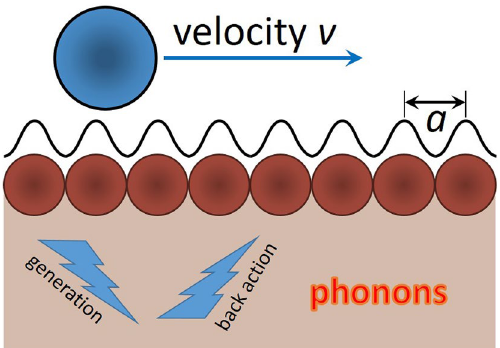
Figure 1. Schematic of the geometry considered in our theoretical treatment. A rigid slider, symbolized here as a single particle, is forced to travel at constant speed over a substrate, with which it experiences a perfectly periodic, sinusoidal interaction. This interaction leads to the excitation of phonons in the substrate, each exerting a force on the slider that oscillates in time. The total force, felt by the slider, is formed by the combination of all these oscillatory, phonon-based contributions. Even when no damping is introduced in this calculation, this combination exhibits the damping characteristics of a genuine friction